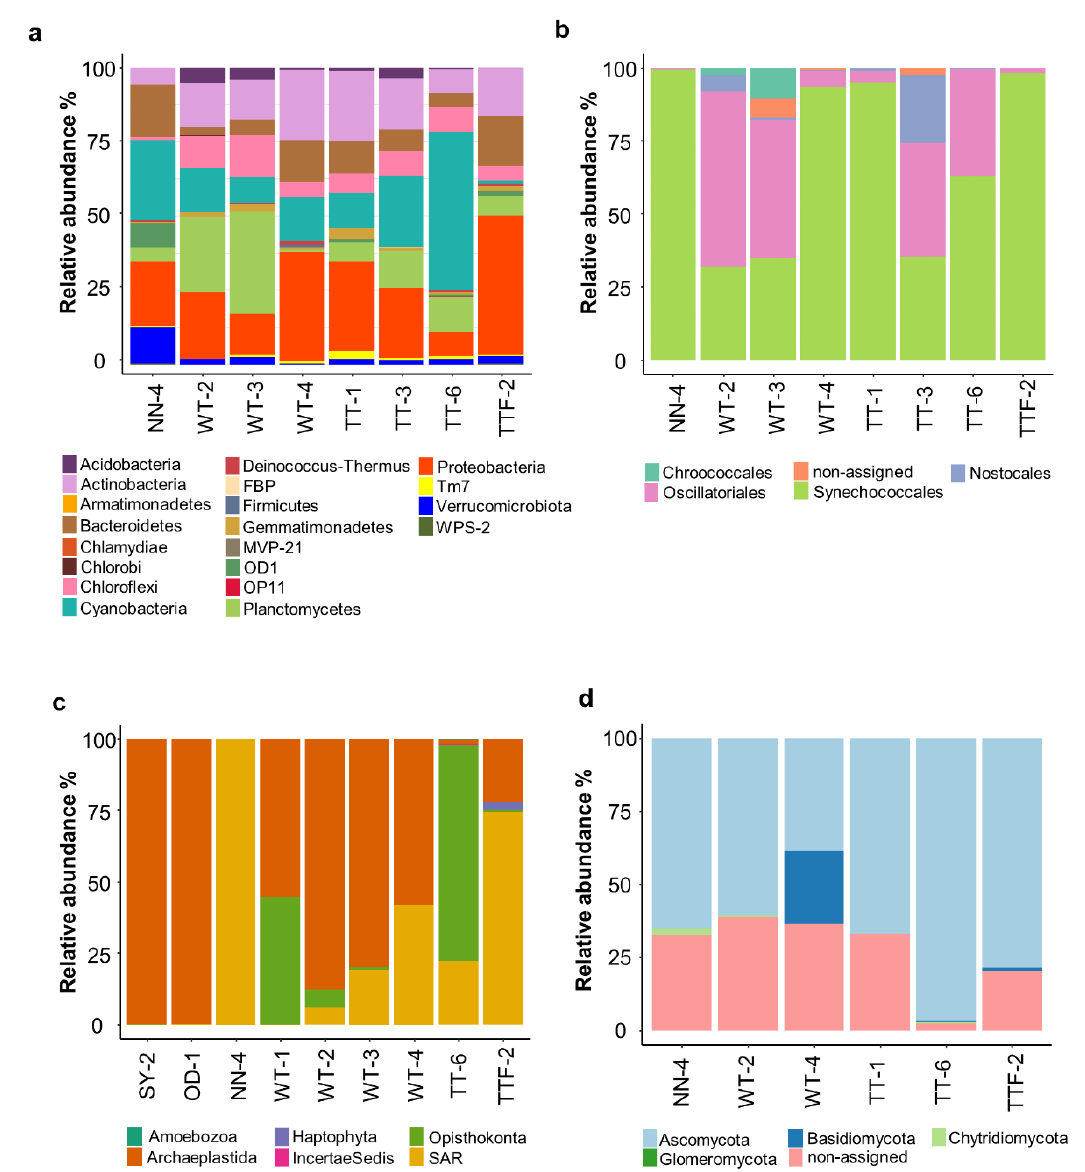
Figure 2. Relative abundance of bacteria ( a ), cyanobacteria ( b ), eukaryotes ( c ) and fungi ( d ) in the studied biocrusts. SY, OD, WT, TT and NN correspond to Shreyahn, Oedesse, Wietze, Teutschenthal and the not named site, respectively.